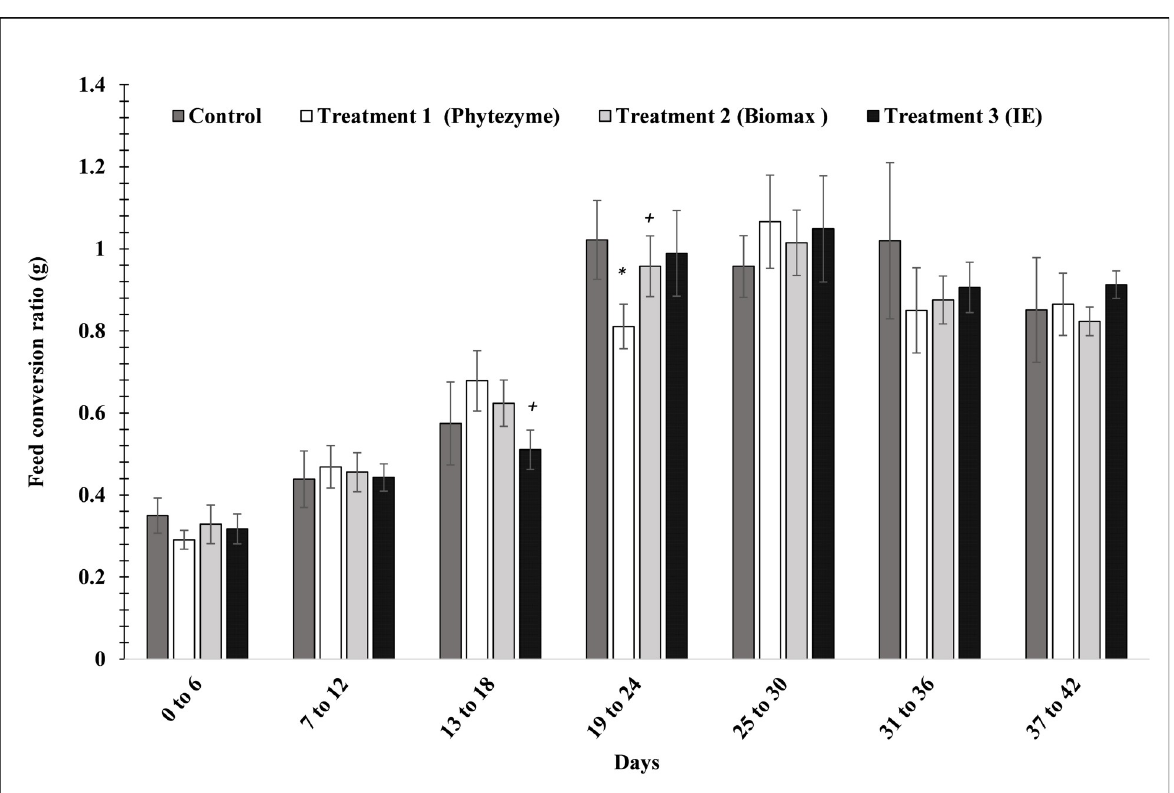
Fig 3. Effects of enzymes’ treatment on FCR in birds. Values represent mean ± (SD). Significant differences by Tukey’s test: � p < 0.01 from control; +p < 0.05 from T1 group.